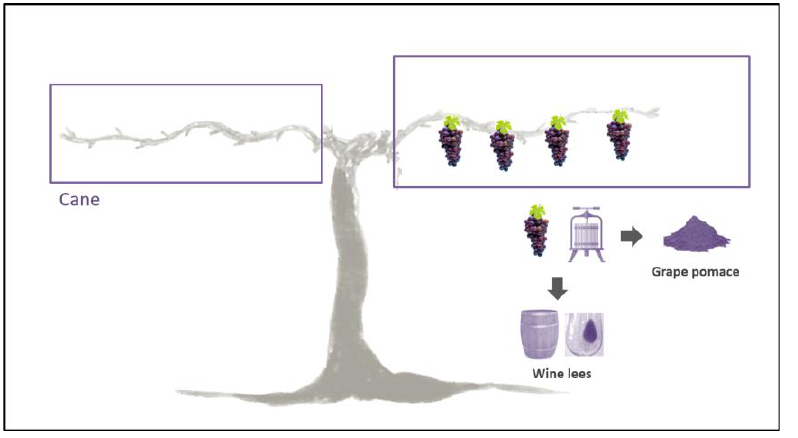
Figure 2. Grape canes, grape pomace and wine lees can be used for the extraction of viniferin.